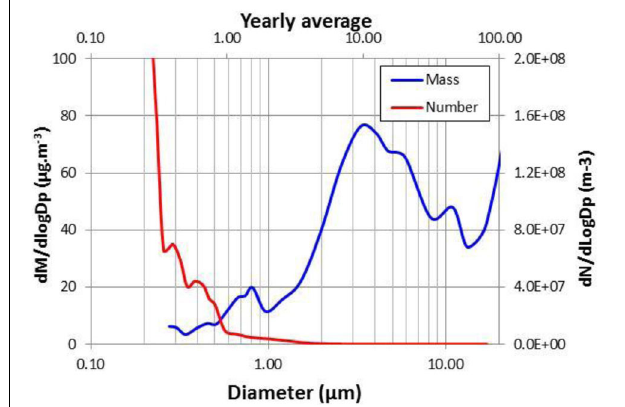
FIGURE 10 | Yearly averaged mass and number concentration size distributions for the Praia atmospheric aerosol during